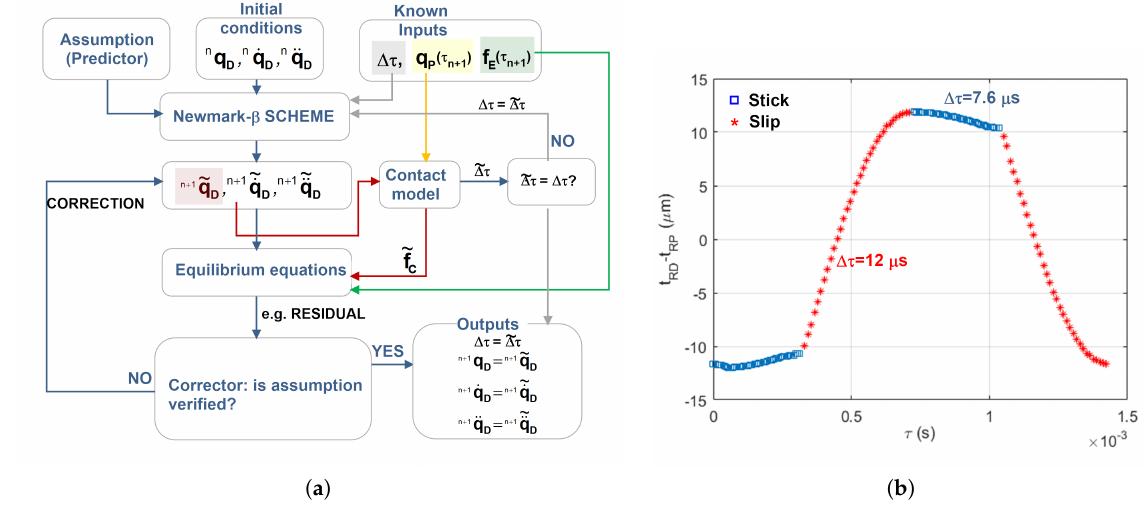
Figure 4. ( a ) Scheme representing the Newmark- β implicit DTI scheme (standard implementation) with an adaptive time step. ( b ) Example of result of Newmark- β DTI with adaptive time step. The adaptive time step can be applied to any DTI algorithm (e.g., Runge–Kutta and Euler) since all methods have limitations on ∆ τ / T